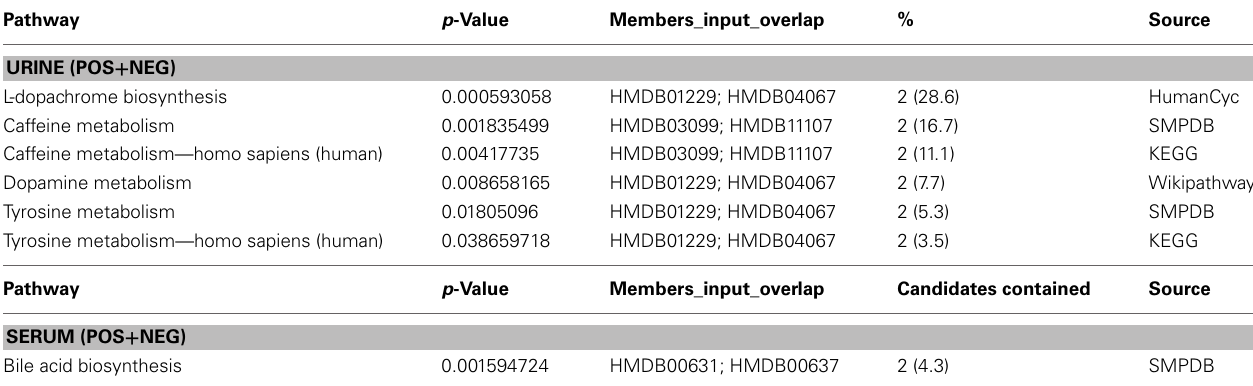
Table 4 | Pathway enrichment analysis. Enrichment of top most informative metabolites in serum and